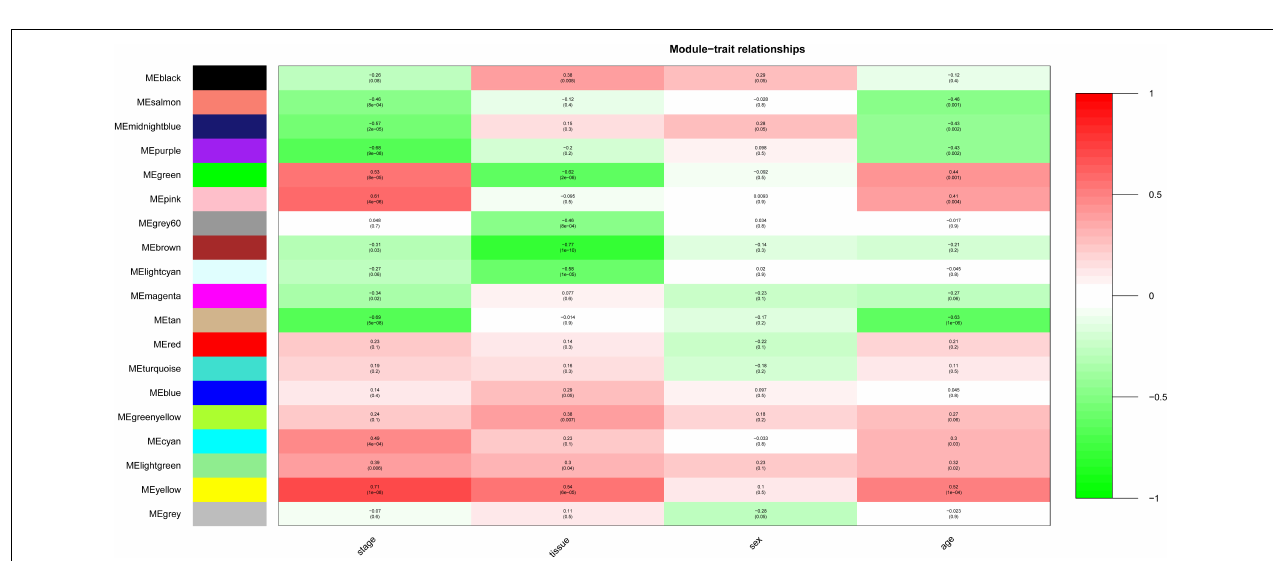
FIGURE 4 | Module-trait relationships. Stage indicates OA and non-OA; tissue indicates samples from LT and MT.